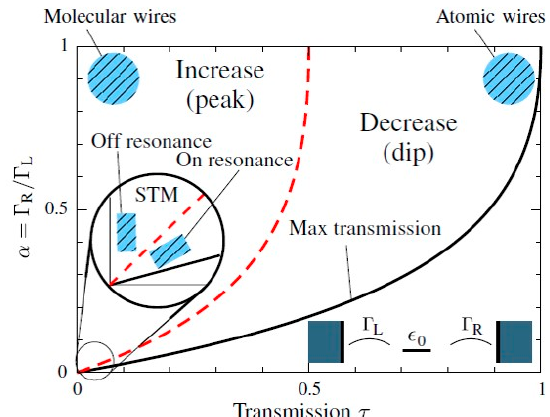
Figure 6. The sign of the conductance change as function of asymmetric factor ( α ) of metal–molecule coupling and transmission of the single-molecule junction, where electrons transport through a single channel. At a given α, the transmission ( τ ) has an upper limit τ max (black curve), and the inelastic conductance change undergoes a sign change at τ crossover = τ max /2 (red dashed curve). Reproduced with permission from [31] copyright Physical Review Letter Publishing Group 2008.